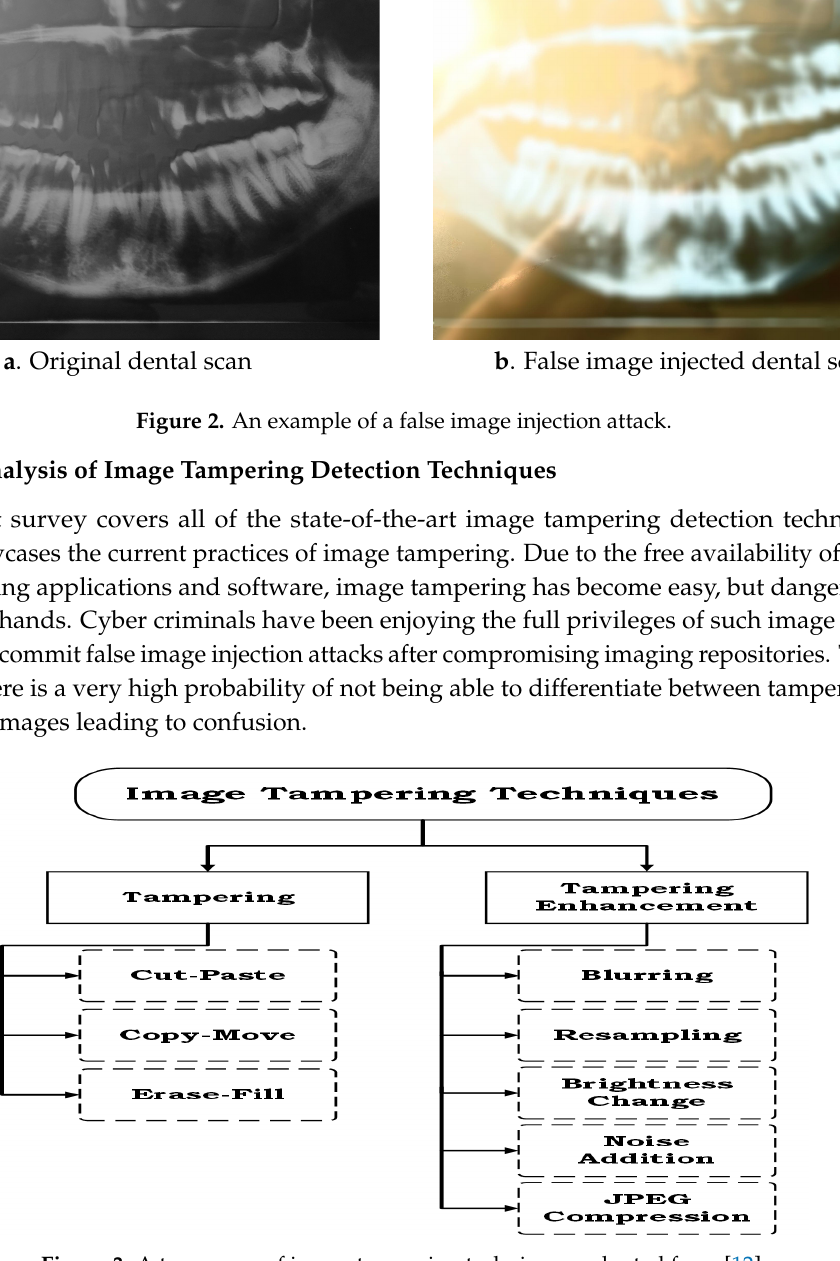
Figure 3. A taxonomy of image tampering techniques, adapted from